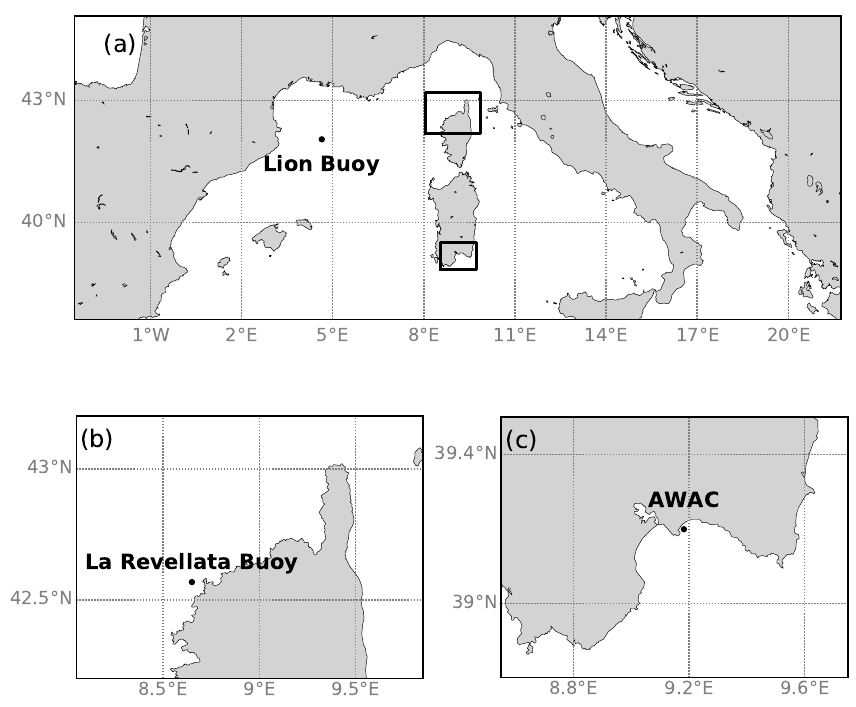
Figure 2. Geographic setting. ( a ) Western Mediterranean Sea; ( b ) Northern Corsica; ( c ) Southern Sardinia. The black dots indicate the location of the wave